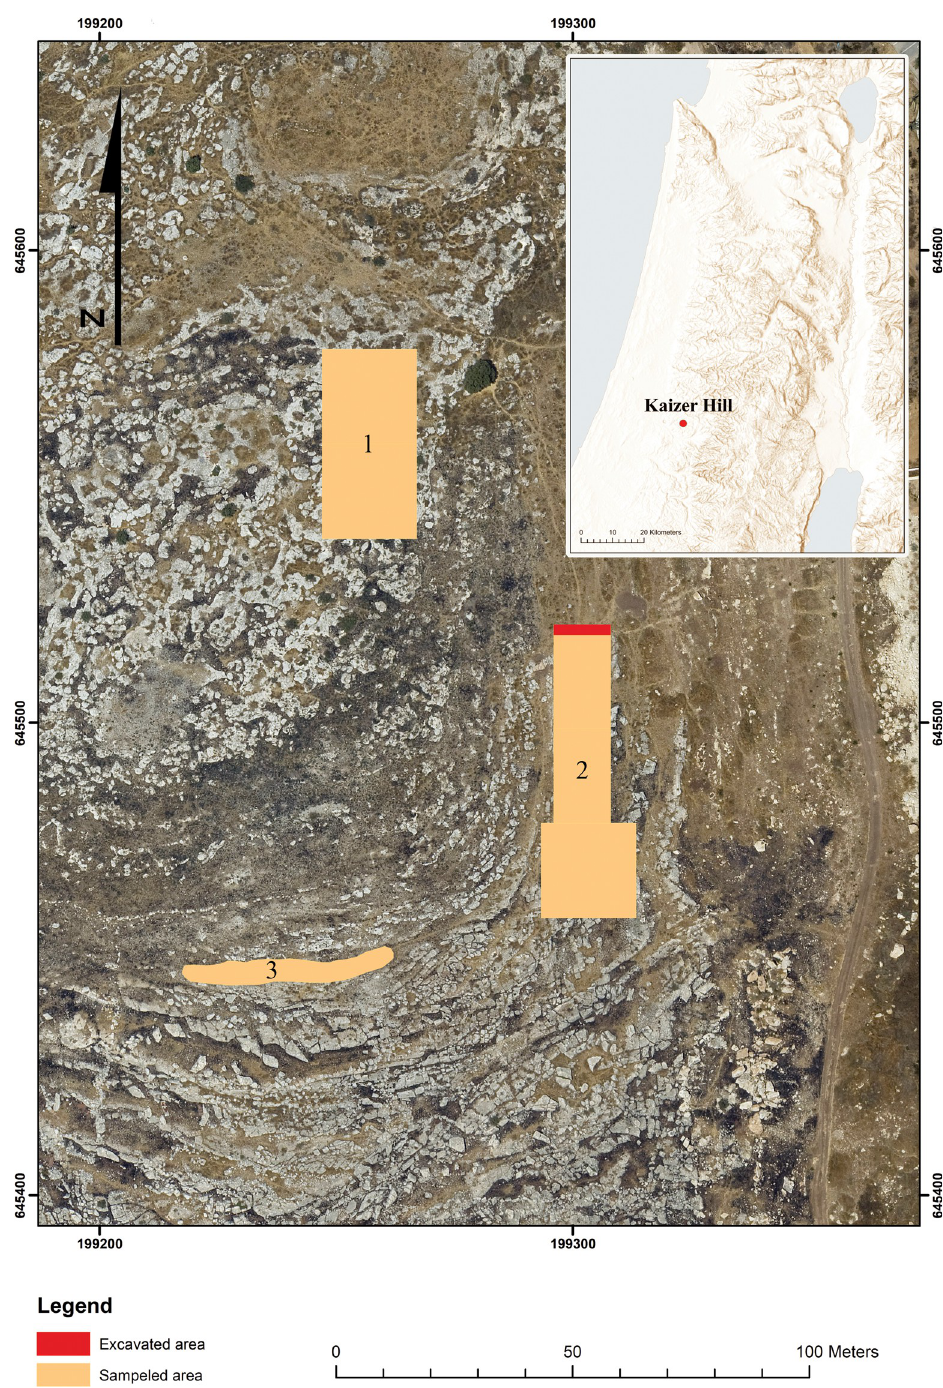
Fig 1. Aerial location map of Kaizer Hill PPNA quarry site. 1) Hilltop; 2) areas of artifacts surface collection, and excavation (in red); 3) surface collection–“above building”. Reprinted from ICAROS Geosystems under a CC BY license with permission from ICAROS, original copyright